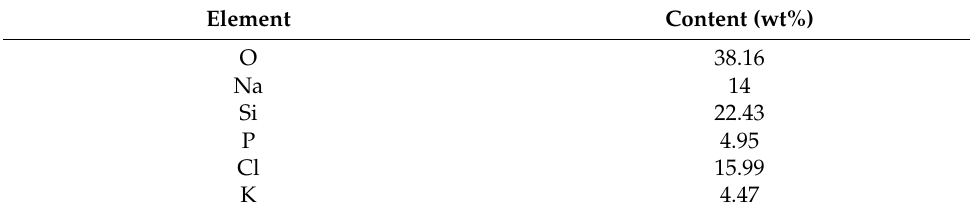
Table 3. EDS element composition on the surface of precipitated silica.